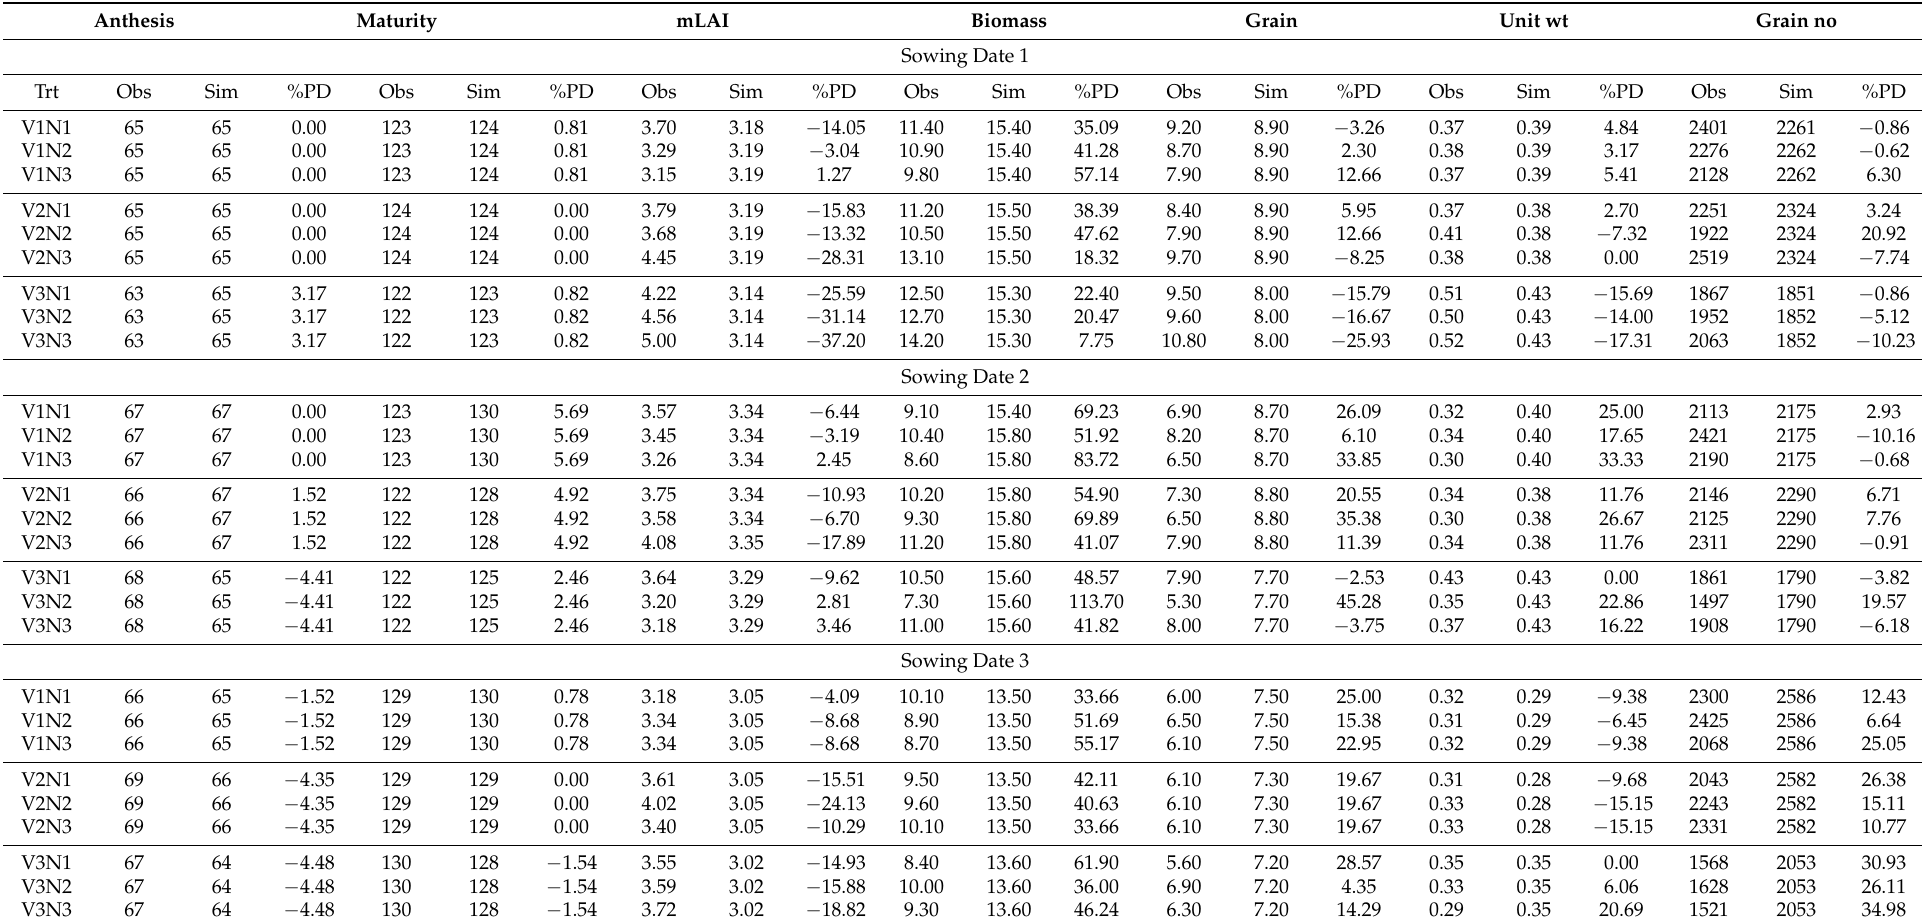
Table A3. Comparison between the observed and simulated phenology, mLAI, biomass, grain and grain size in the APSIM-Maize model under the rainfed condition. Reproduced with permission from